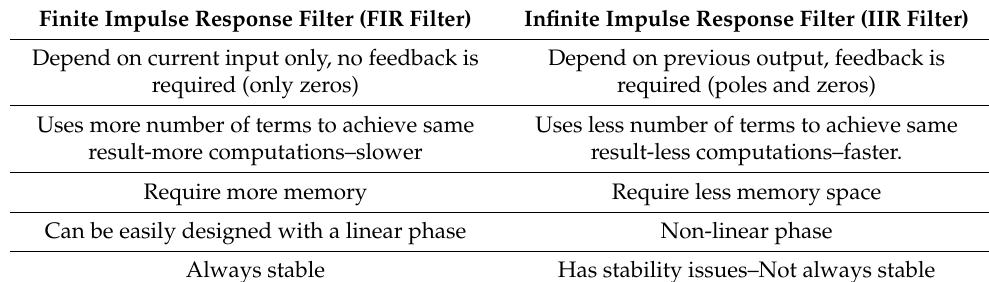
Table 1. The difference between FIR and IIR